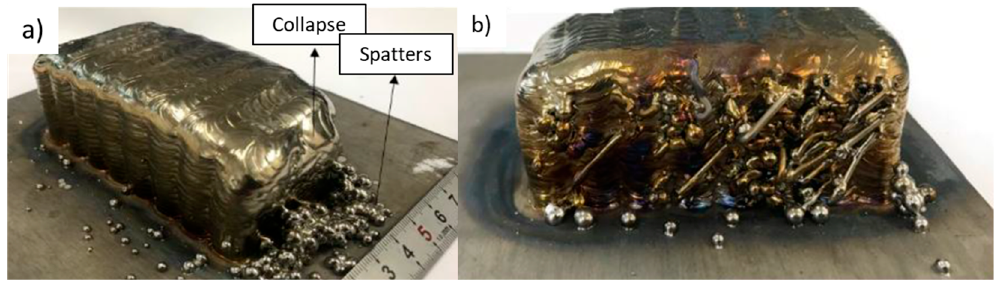
Figure 30. Image of WAAM macro defects: ( a ) side collapse; ( b ) unmelted wire (adapted from [147]).